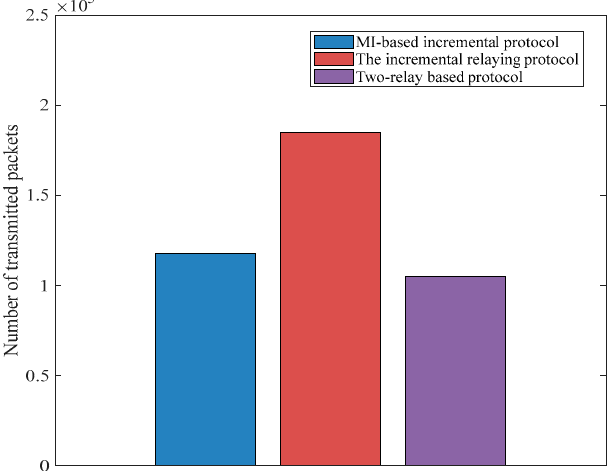
Figure 6. The path loss performance versus the network lifetime.